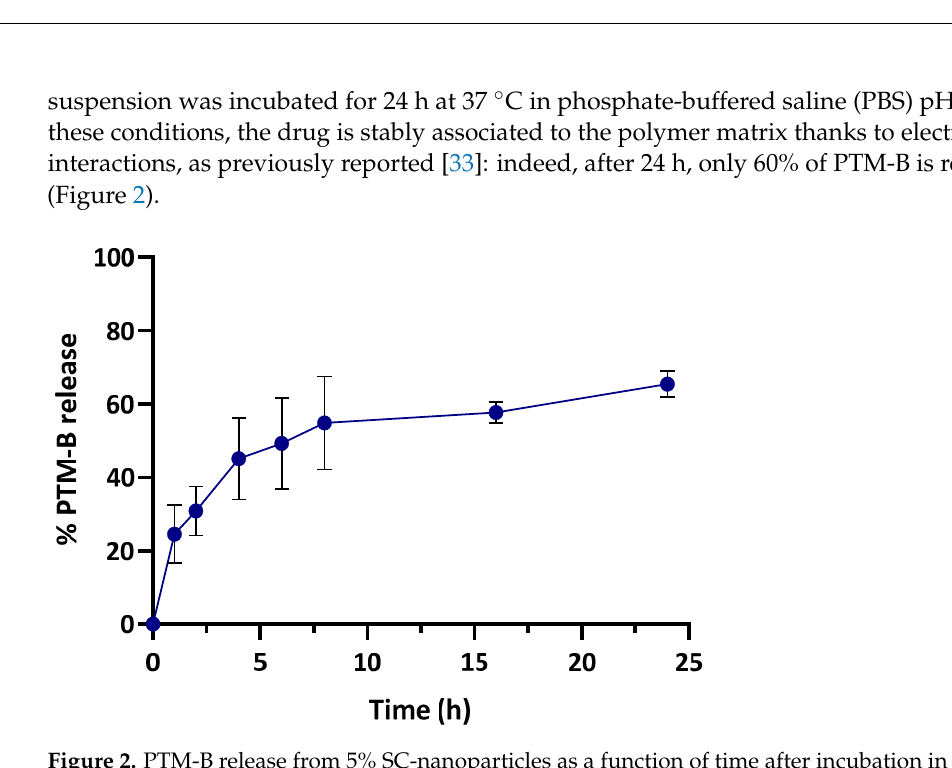
Figure 2. PTM-B release from 5% SC-nanoparticles as a function of time after incubation in PBS pH 7.4 at 37 °C.